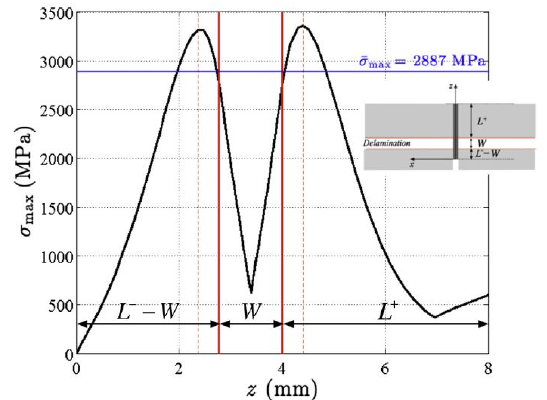
Figure 27. Predicted maximum normal stress distribution along the z-Pin for mode mixity ratio F igure 27. Predicted maximum normal F igure 28. Predicted maximum shear 0.55 stress distribution along the z-Pin for mode stress distribution along the z-Pin for mixity ratio 0.55 [12]. mode mixity ratio 0.55 [12]. F igure 27. Predicted maximum normal F igure 28. Predicted maximum shear stress distribution along the z-Pin for mode stress distribution along the z-Pin for mixity ratio 0.55 [12]. mode mixity ratio 0.55 [12].